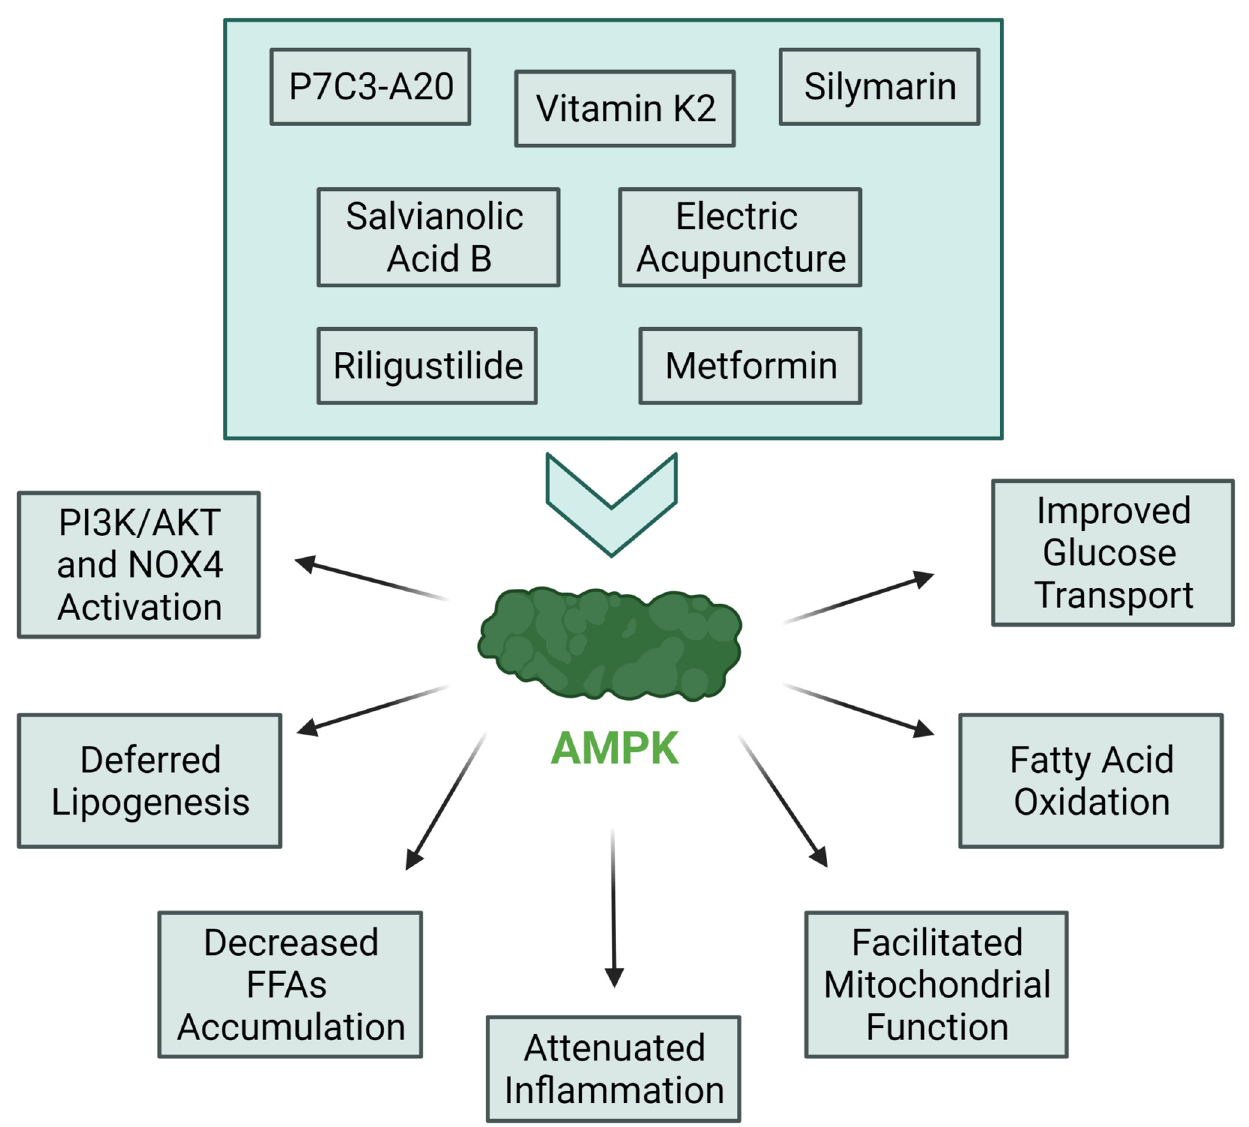
Figure 3. Schematic graph showing the effects of various agents on AMPK signalling with their subsequent impacts. Recently, many different agents targeting the AMPK-related pathways have been proposed as a novel approach for IR treatment. Using them leads to improved glucose and lipid metabolism and attenuates inflammation and oxidative stress parameters, as well as stimulating molecular pathways that are protective against IR progression [52–59].